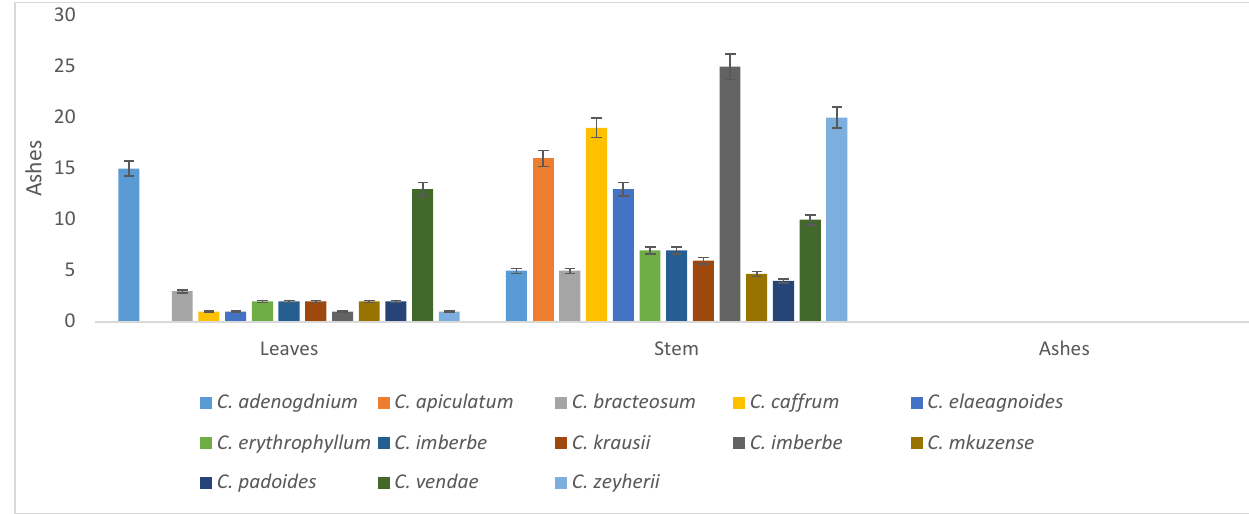
Ash percentage ranged from 1–15 in the leaves and 4–35 in the stems. The leaves of C. vendae and C. adenogdnium had the highest ash levels. Generally, the stems (83%) had the highest ash percentage levels when compared to the leaves (17%), as shown in Figure 7.